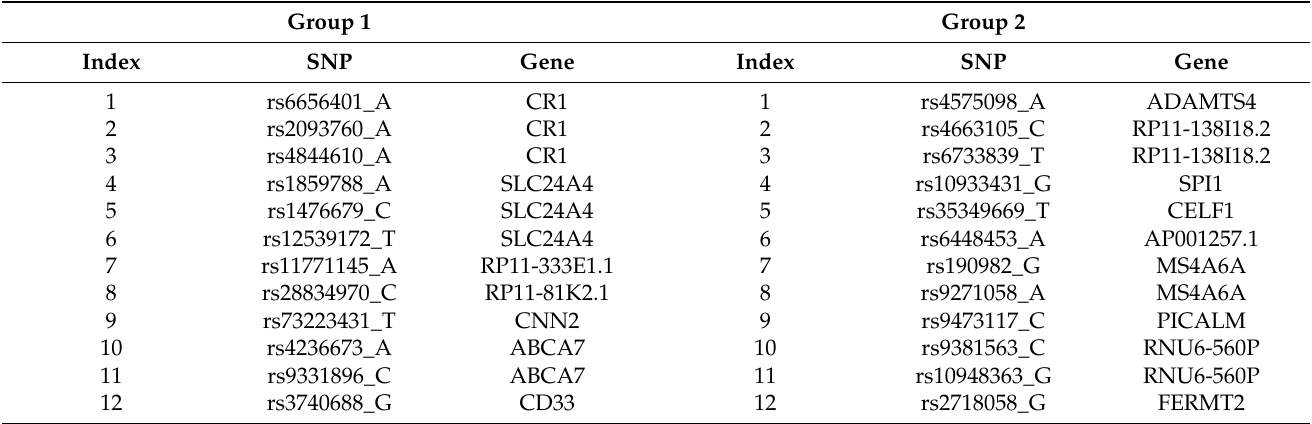
Table A5. SNP clustering result on the VBM measures for the AD vs. HC comparison. The SNP and the corresponding closest genes are listed for each resulting cluster or